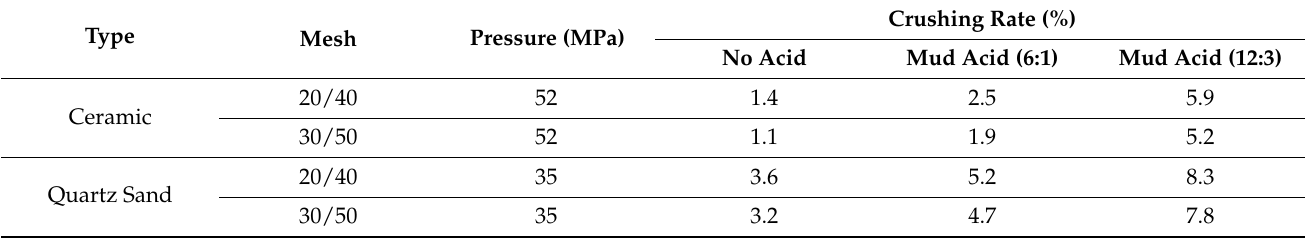
Table 3. Changes in compressive strength after acid